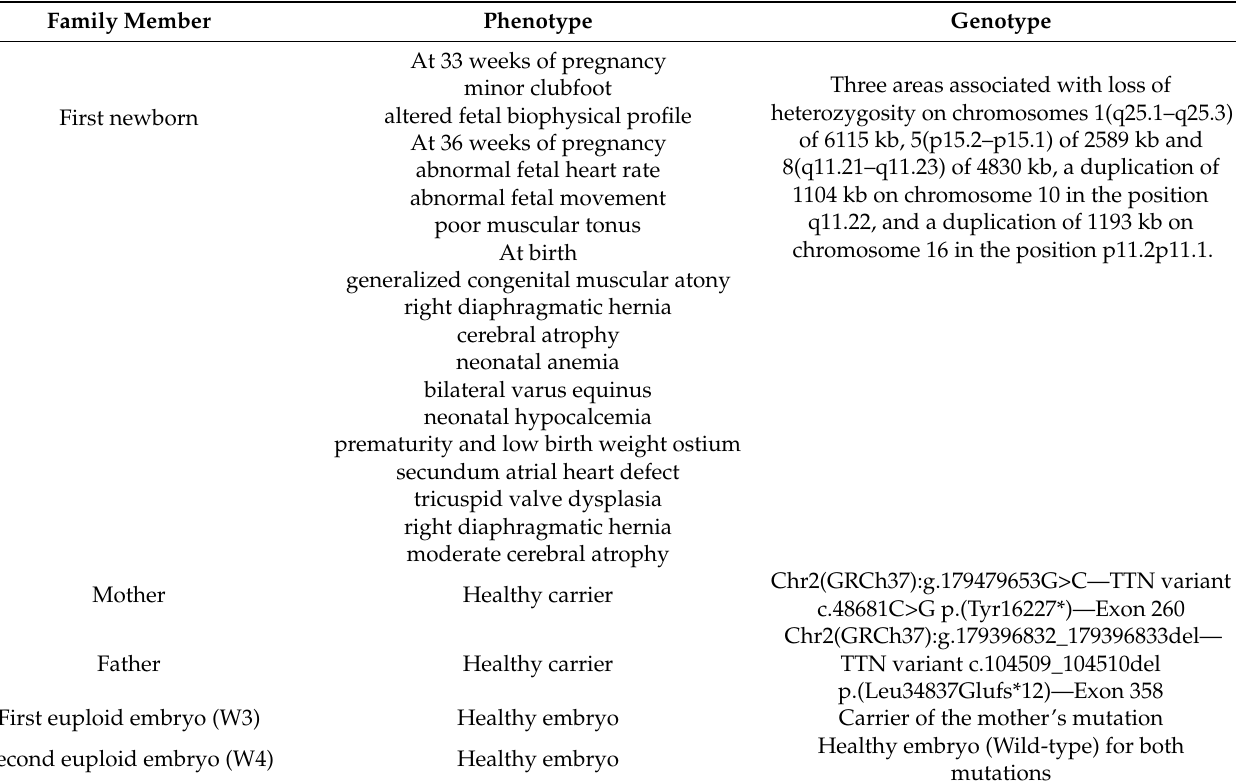
Table 1. Phenotype-genotype features of the family